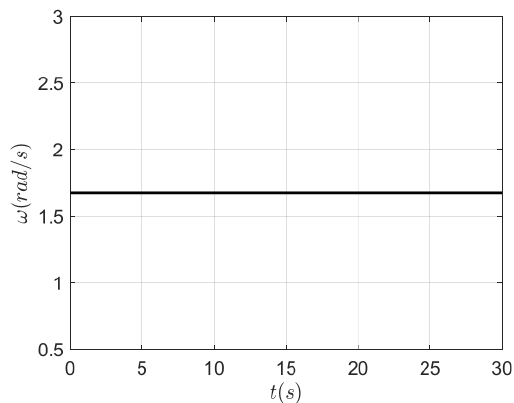
Figure 4. Angular velocity of the crank - case study 1